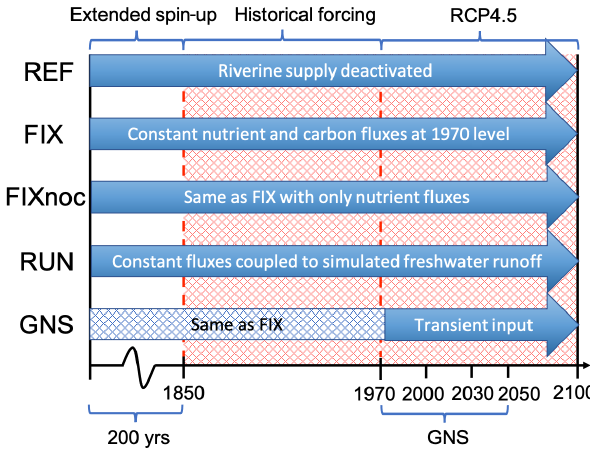
Figure 1. Schematic illustration of the spin-up and integration pro- cedure following the experimental design described in Sect.